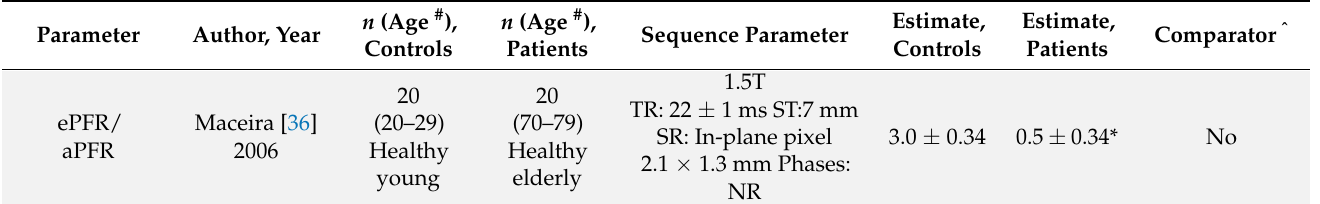
Table 7. LV time/volume curves—early peak filling rate indexed to active peak filling